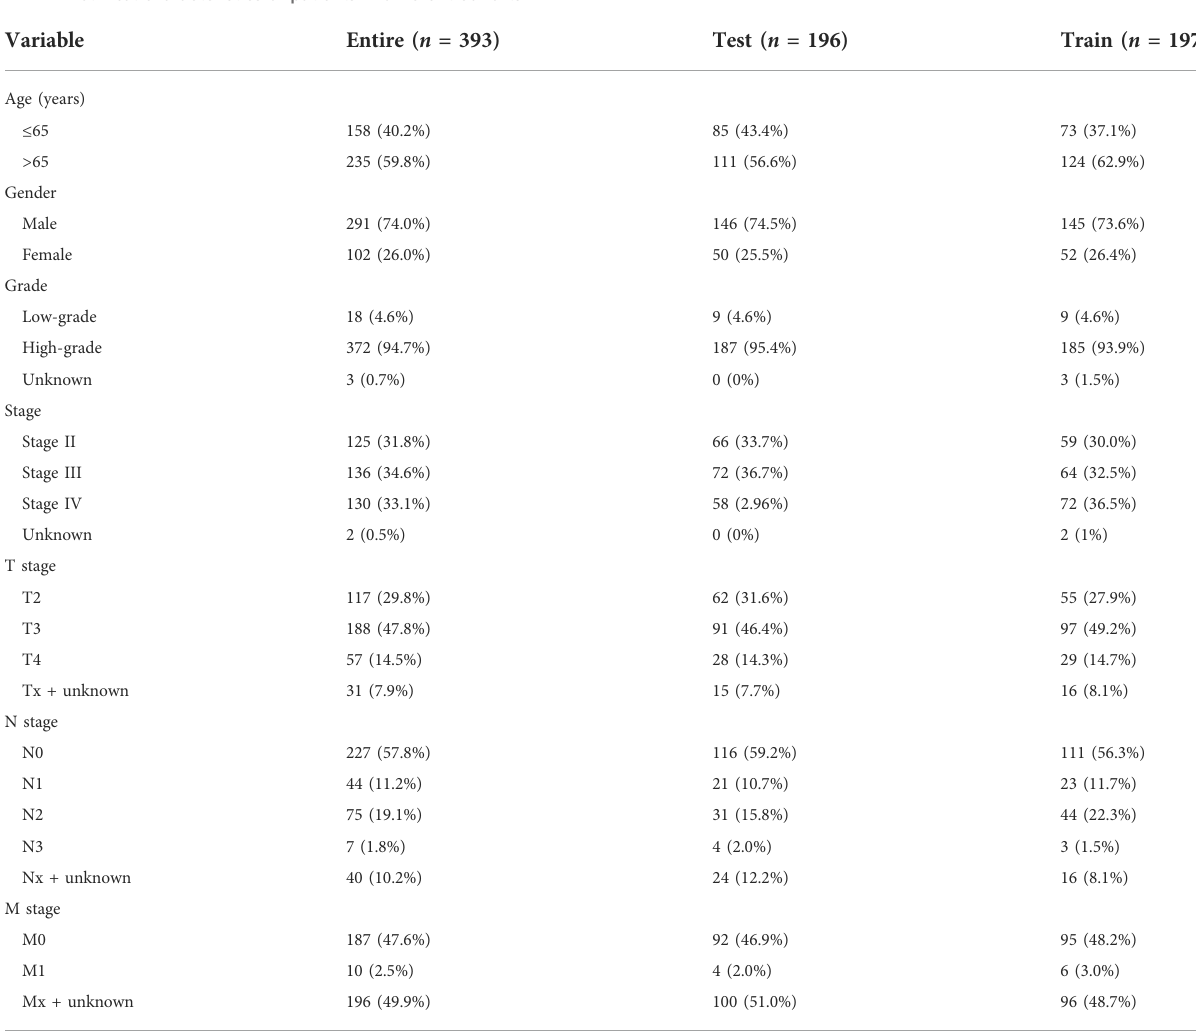
TABLE 1 Clinical characteristics of patients in different